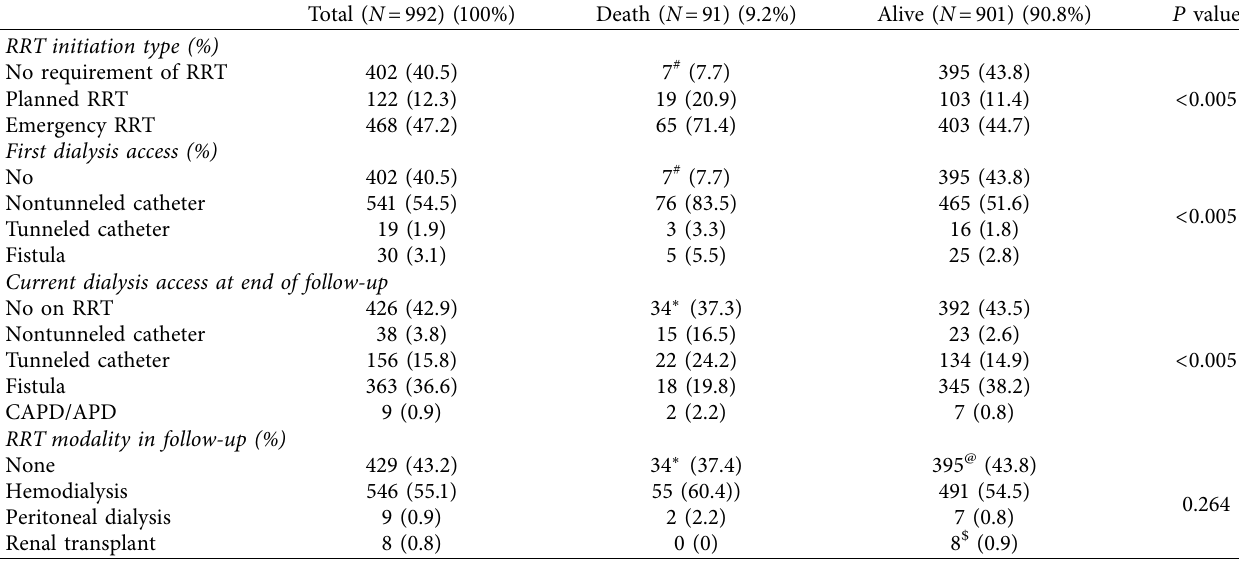
Table 7: Differences in outcome-related characteristics regarding dead and alive patients on